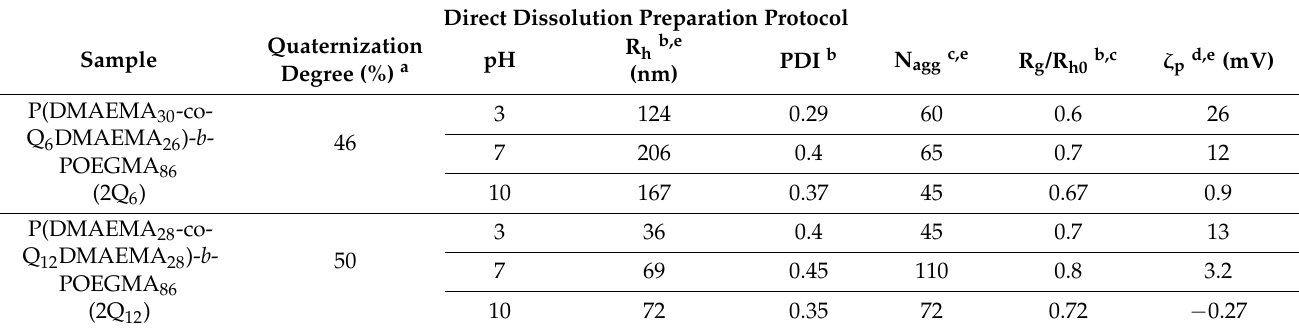
Table 3. Physicochemical features of the P(DMAEMA 30 -co-Q 6 DMAEMA 26 )- b -POEGMA 86 and P(DMAEMA 28 -co- Q 12 DMAEMA 28 )- b -POEGMA 86 , at direct dissolution protocol and solution concentration c = 5 × 10 − 3 g/mL, extracted from pH-response